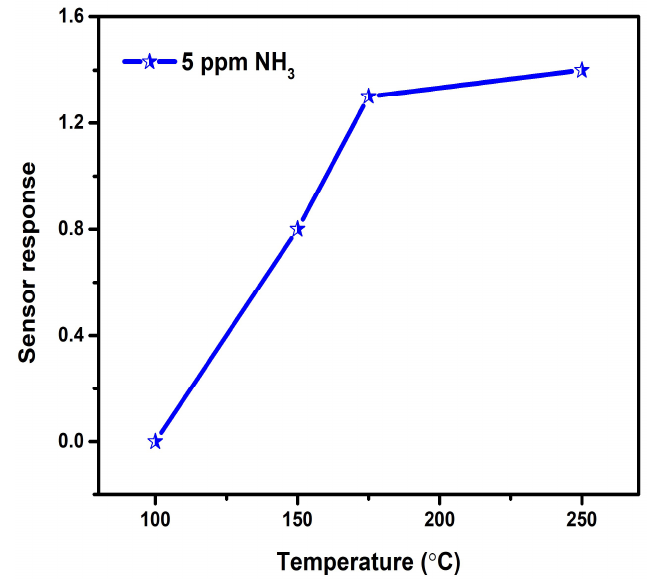
Figure 6. Temperature optimization plot of Zn: WO 3 .